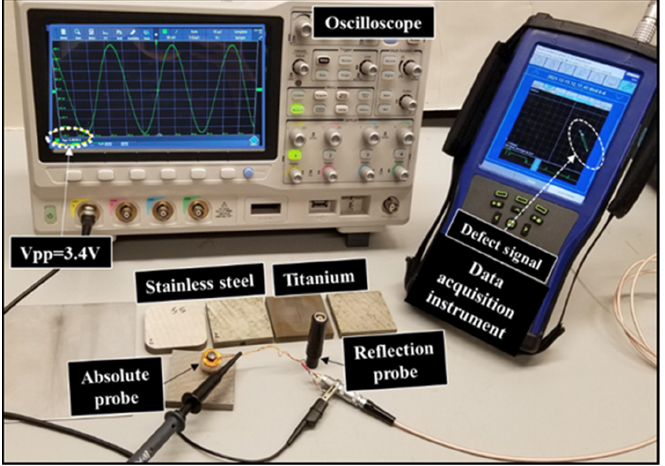
Figure 9. Experimental setup showing both probes used to test titanium and stainless-steel